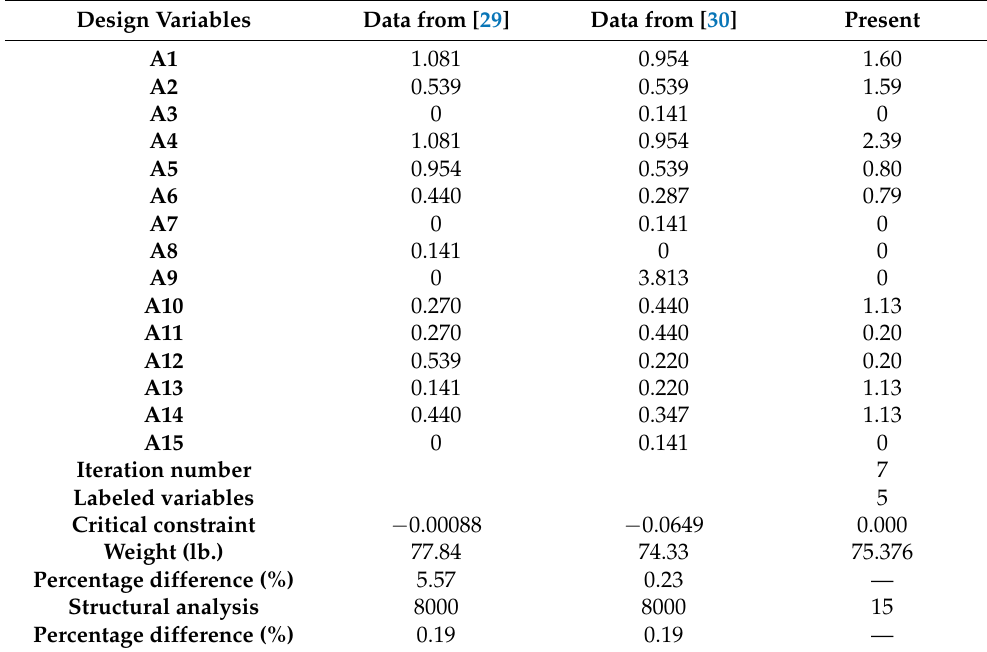
Table 2. Optimization results of the 15-bar truss.